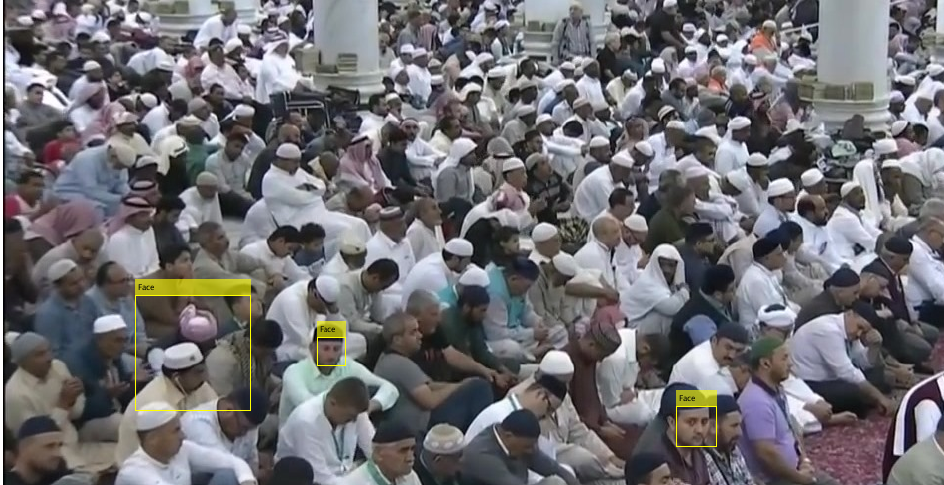
Figure 7. Detected face regions.